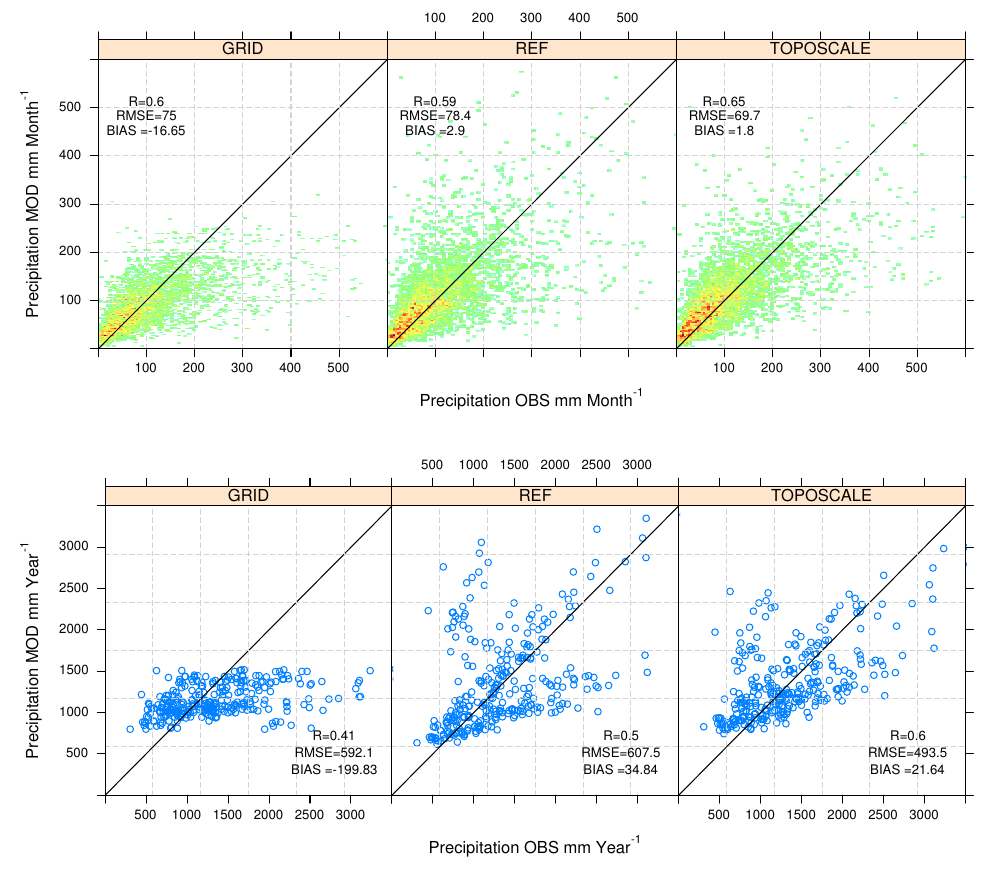
Fig. 9. Performance of TopoSCALE precipitation at monthly and annual scales compared to GRID and REF. The description of the spatial distribution of precipitation included in TopoSCALE gives improvements over a purely lapse-rate-based approach